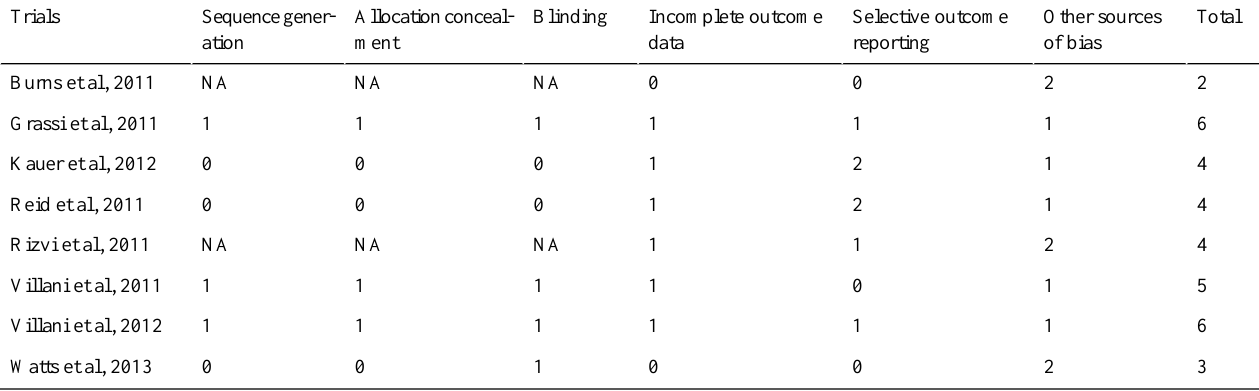
Table 2. Risk of bias assessed by Cochrane Risk of Bias Tool a